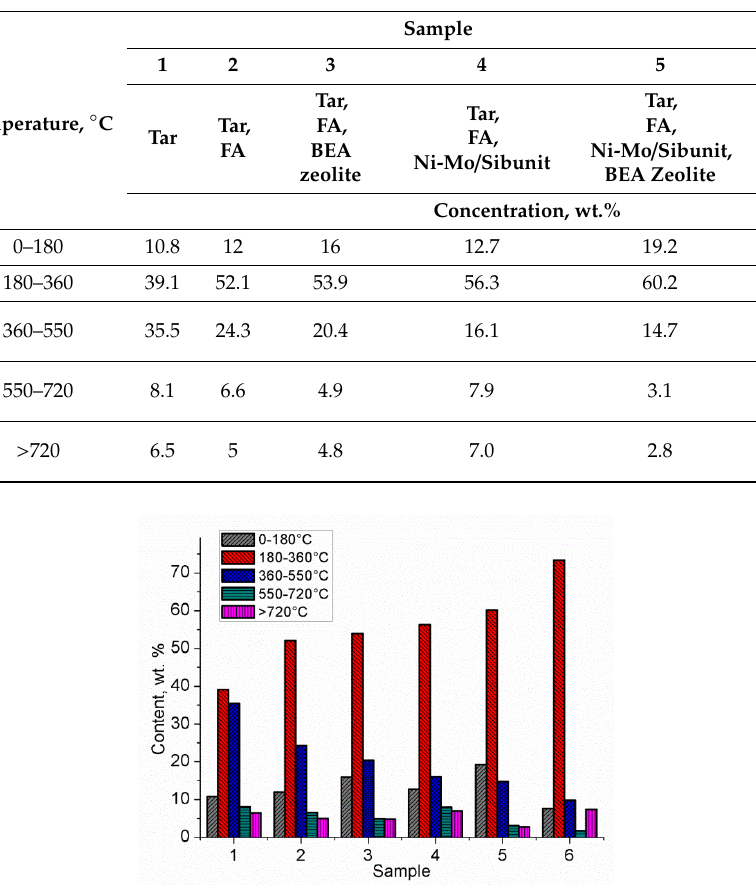
Figure 5. Fraction composition of liquid products.